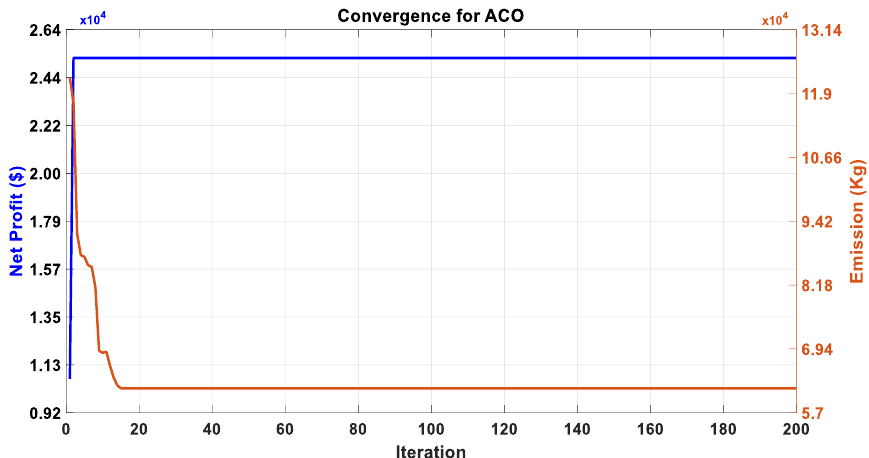
Figure 20. Convergence curve of the ABC algorithm.